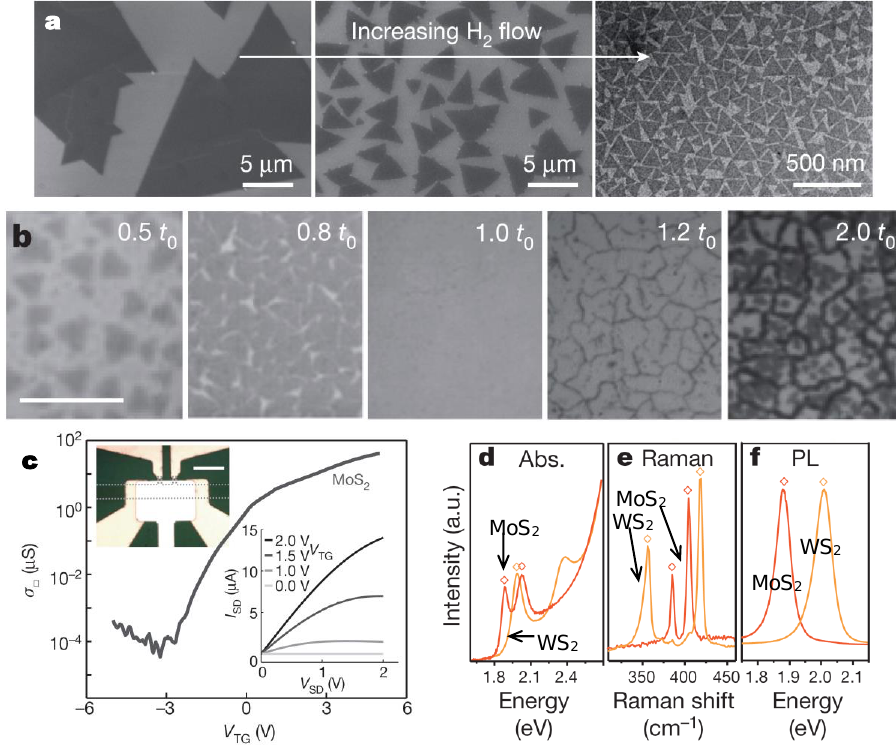
Figure 5. ( a ) Grain size evolution of monolayer MoS 2 as a function of H 2 flow. From left to right, 5, 20 and 200 sccm H 2 . ( b ) Optical images of MoS 2 films as a function of growth time. t 0 is the optimal time for full monolayer coverage (~26 h). ( c ) Transfer and output properties of the field-effect transistor fabricated in the MOCVD grown MoS 2 with top gate configuration. σ □ denotes sheet conductance. Scale bar: 10 µ m. ( d )–( f ) Optical absorption, Raman and normalized photoluminescence spectra of as-grown monolayer MoS 2 (red) and WS 2 (orange) films. The peak positions in (d)–(f) are consistent with exfoliated flakes (denoted by diamonds)